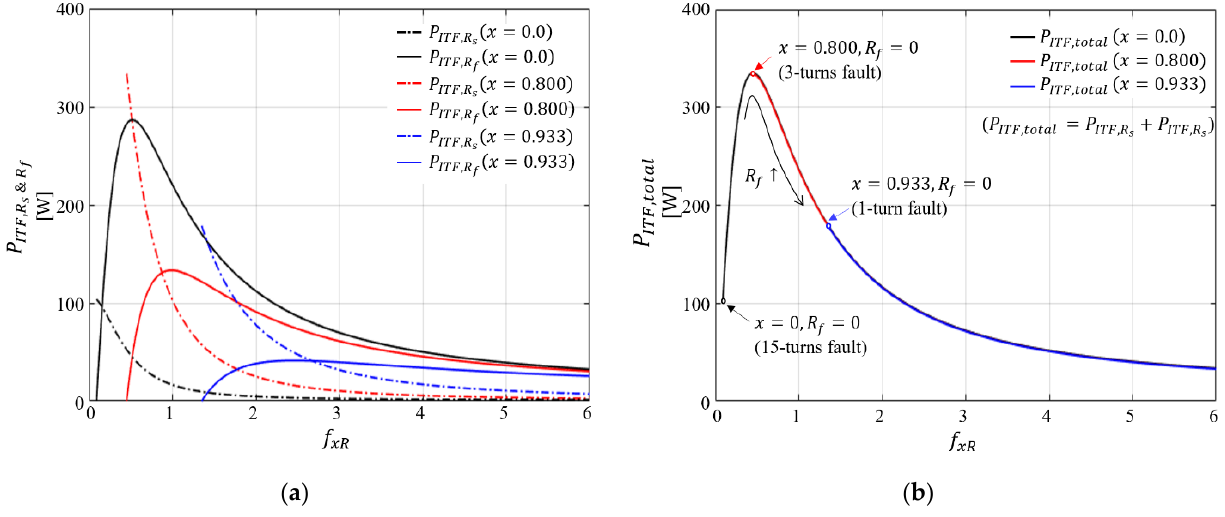
Figure 4. Calculated power losses, ( a ) P ITF , R 0.933 .